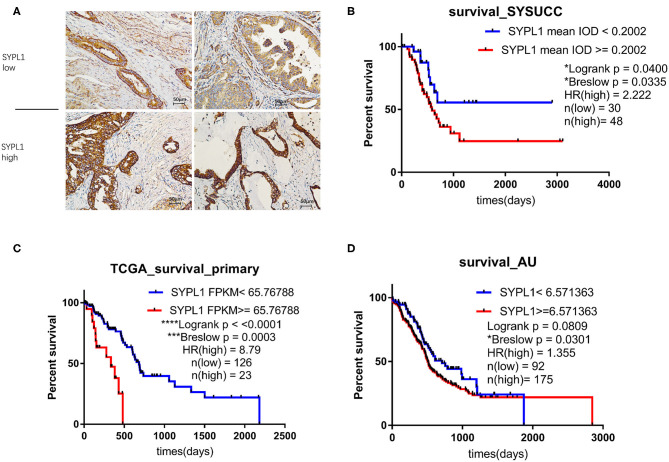
Upregulation of SYPL1 indicated poor prognosis. (A) Two examples of SYPL1-high and SYPL1-low tumor sections. (B) Prognostic effects of SYPL1 on patients from Sun Yat-sen University Cancer Center. (C) Prognostic effects of SYPL1 for patients from TCGA. (D) Prognostic effects of SYPL1 for patients from PACA-AU.